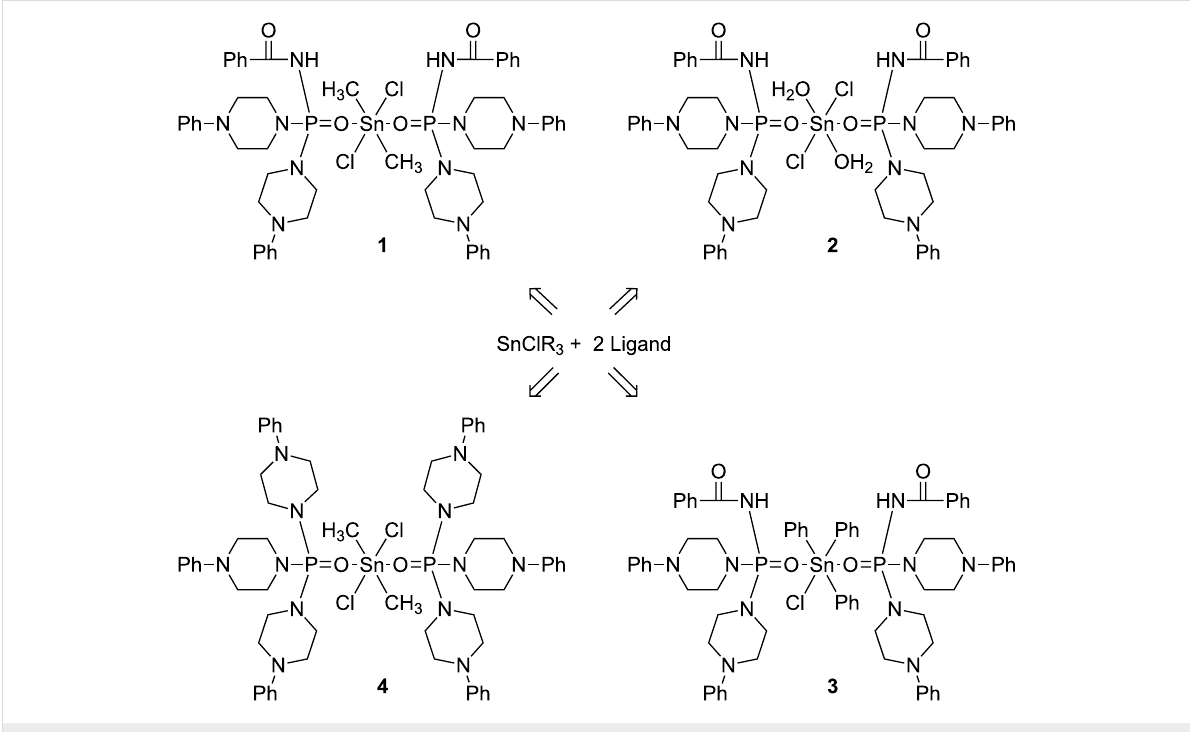
Scheme 1: The preparation pathway of organotin(IV) complexes 1 – 4